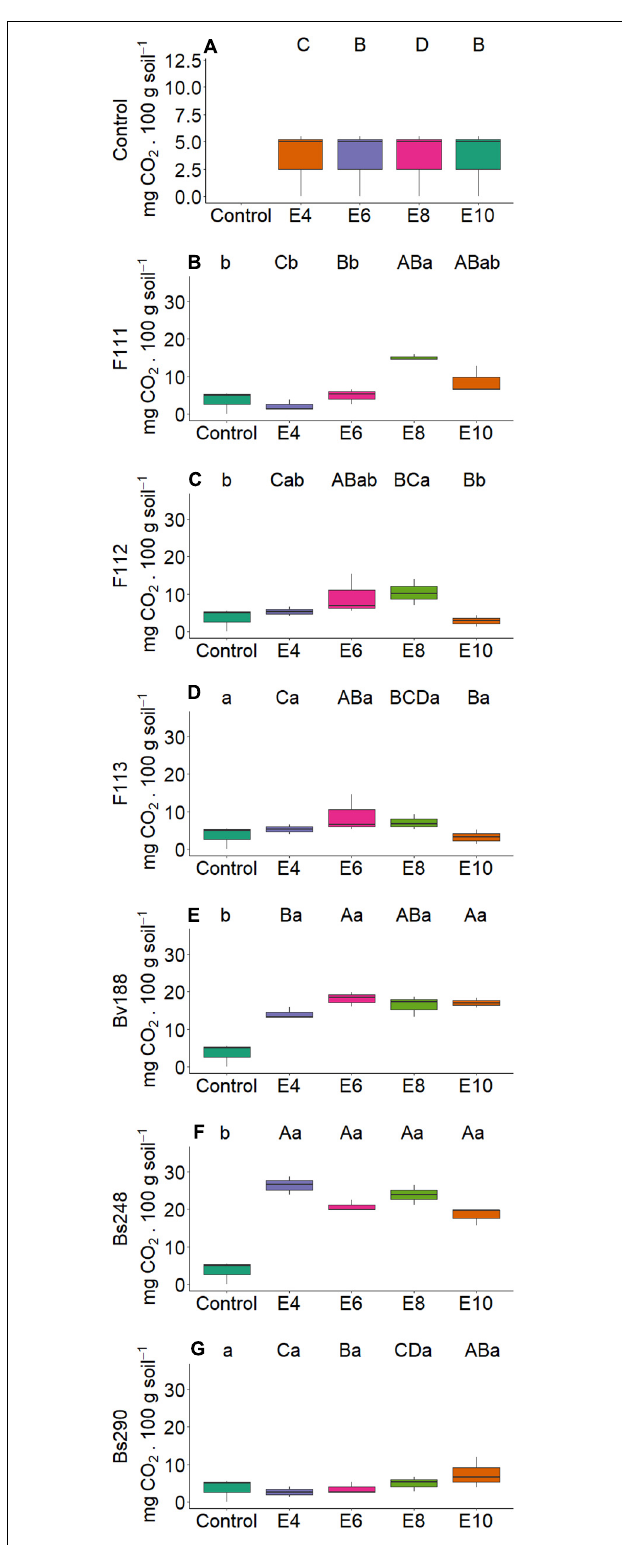
FIGURE 6 | Boxplots (median and quartiles) of respiratory activity in soil sown with cotton and inoculated with plant growth-promoting